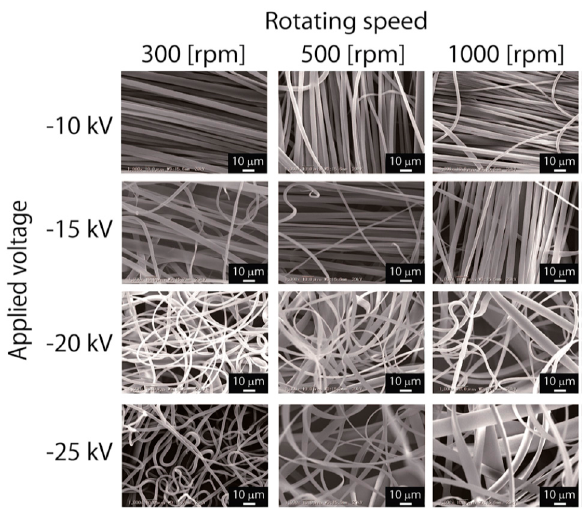
Figure 19. SEM images of PVDF fibrous mats prepared by melt-electrospinning at various applied voltages and collector rotating speeds. The laser output power and the polymer feed rate were fixed at 53 W and 1 mm min − 1 , respectively. Reproduced with permission from [160], published by Royal Society of Chemistry, 2017.